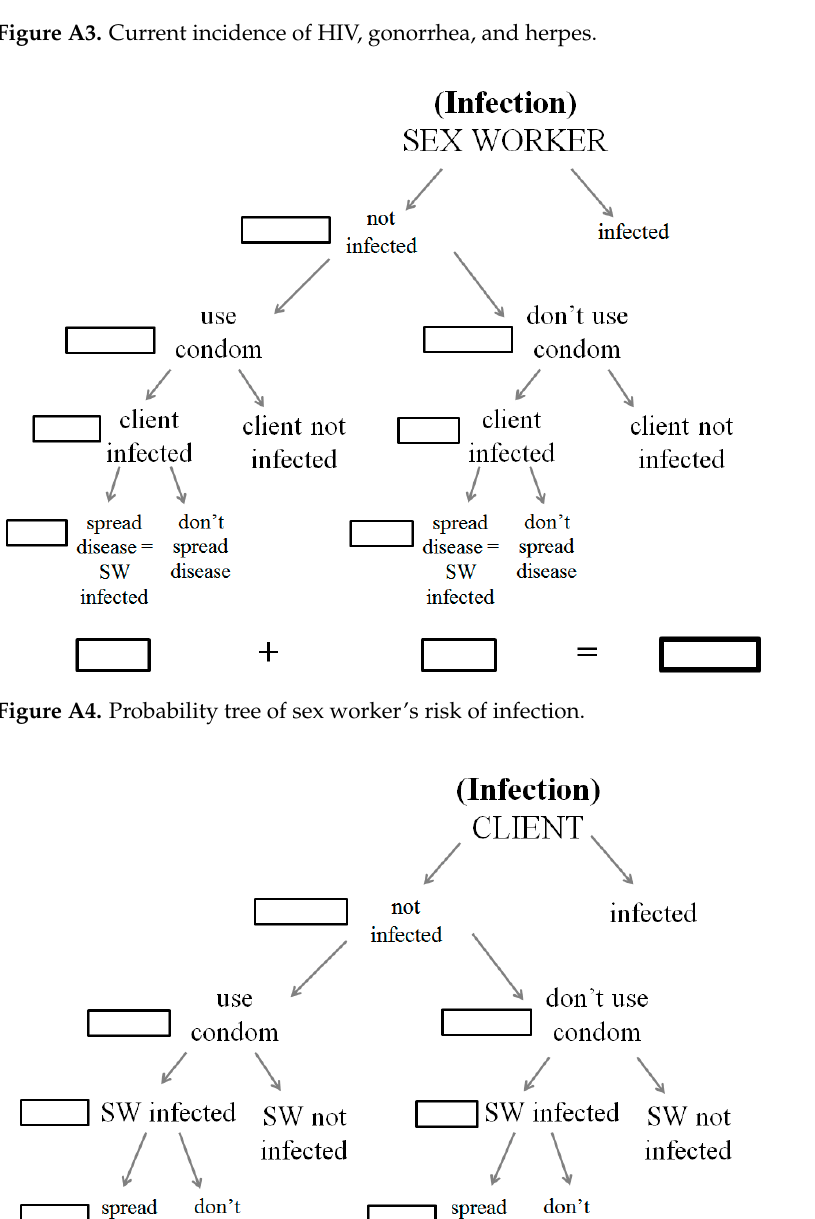
Figure A3. Current incidence of HIV, gonorrhea, and herpes.